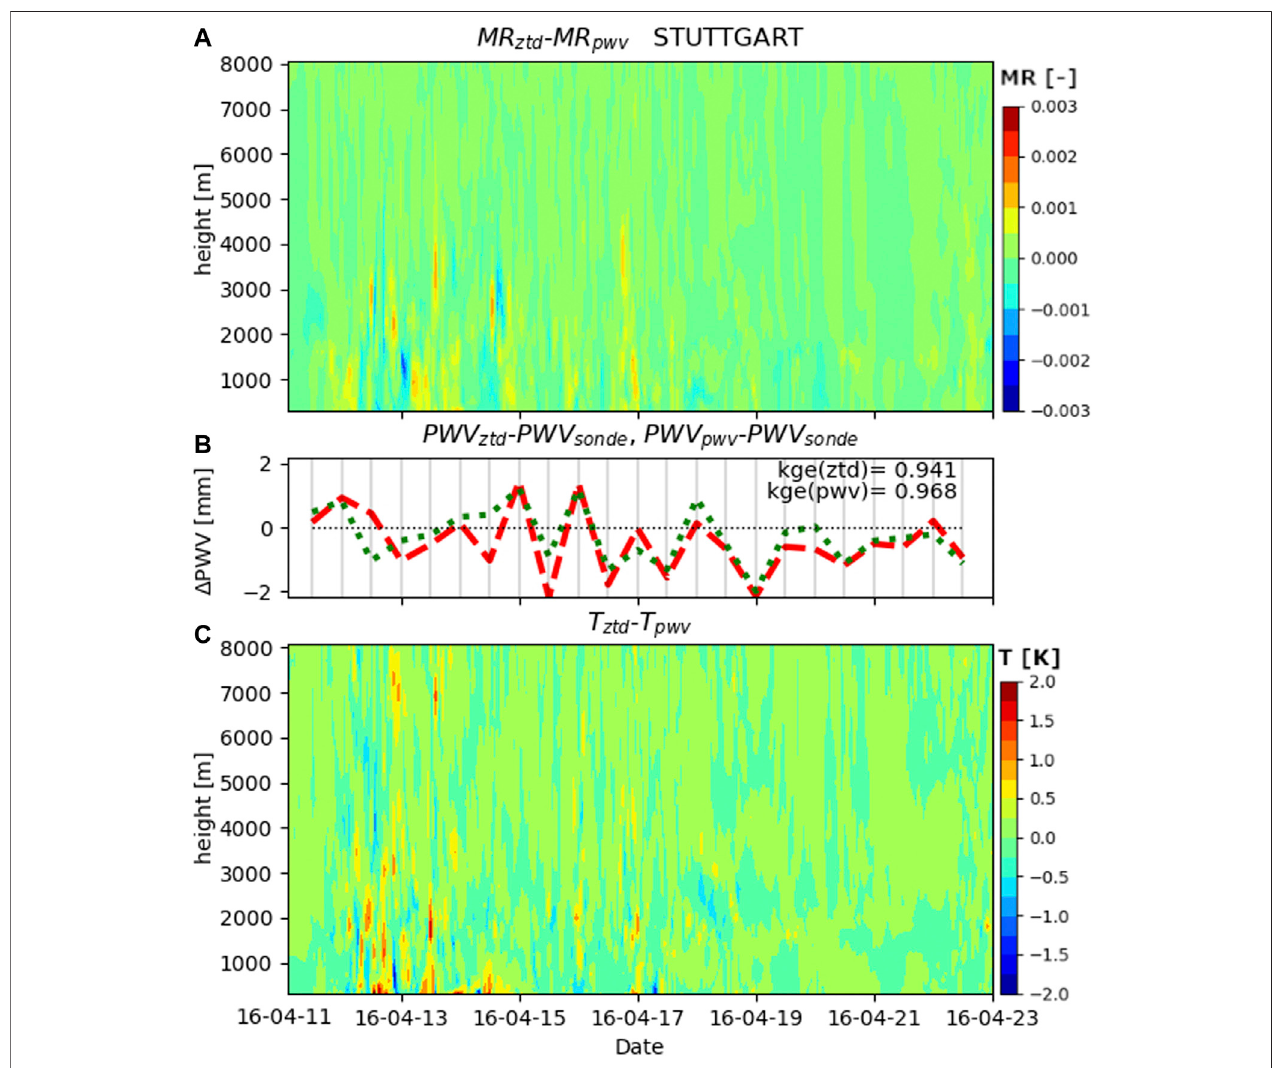
FIGURE 3 | Difference of the mixing ratio (MR) with height (A) and temperature (T) (C) for assimilating ZTD (red) and PWV (green) at the Stuttgart location for the spring episode and difference of corresponding PWV values and radiosonde data (B) .